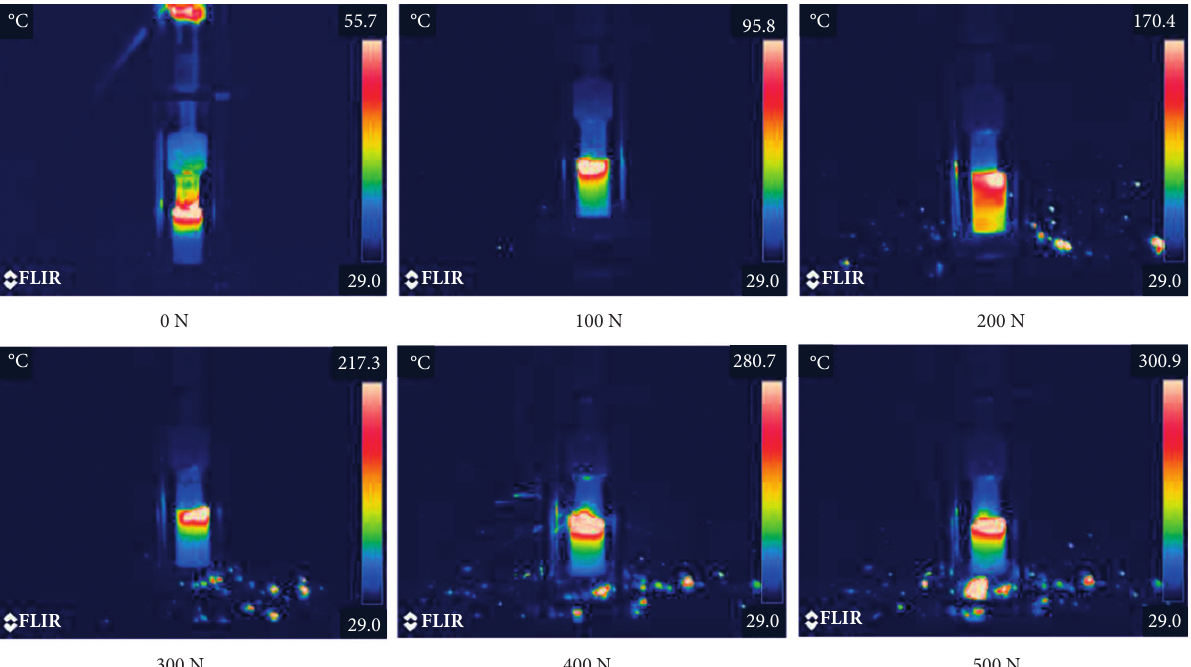
Figure 8: Temperature field of rock surface under different static loadings.